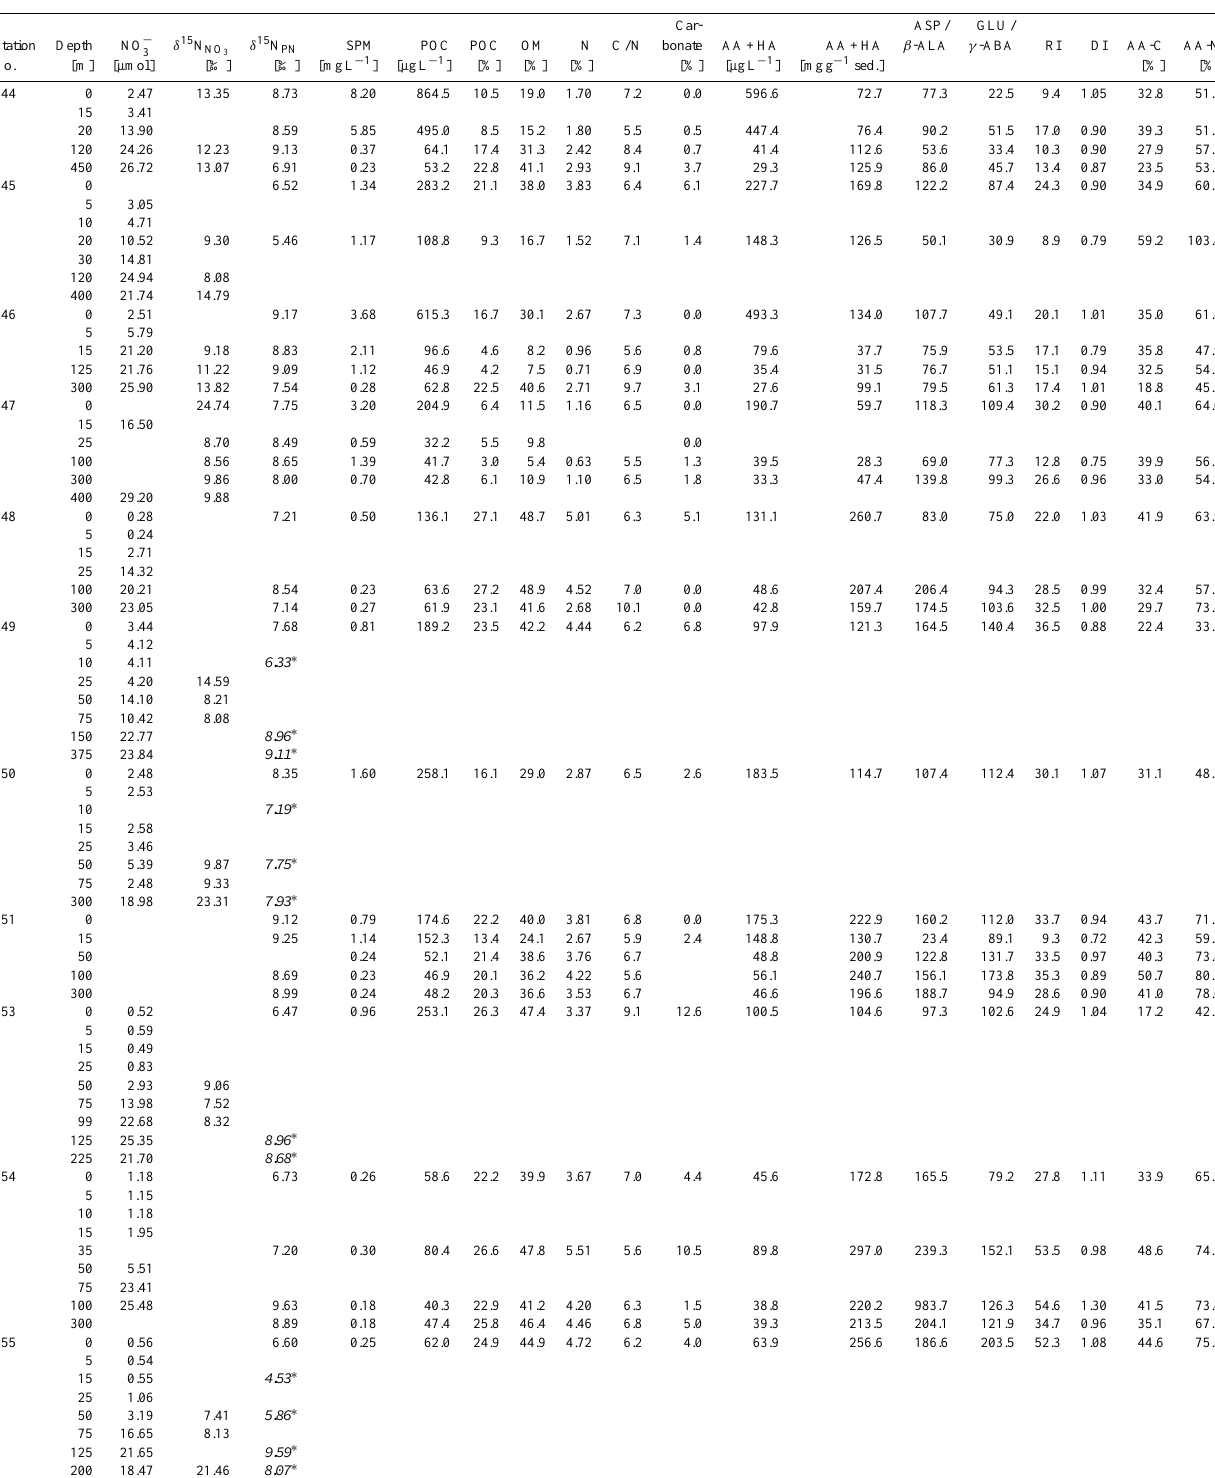
Table 1. Station number, sampling depth, nitrate concentration (NO 3 ), δ 15 N NO OM and N percentages, C/N atomic ratio, carbonate percentage, AA and HA concentration, ratio of Asp/ β -Ala, Glu/ γ -Aba, RI, DI (see text for explanation of these indices), AA-C% and AA-N%. Italics with asterisks mark samples from deep-sea pumps.